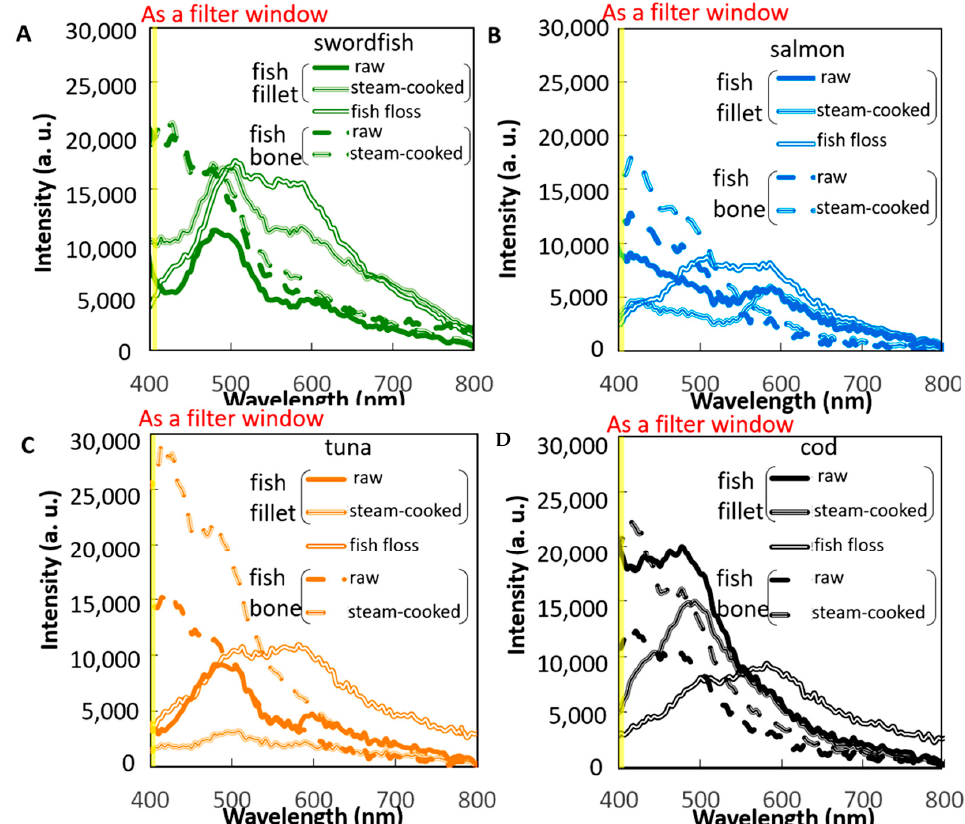
Figure 5. Fluorescent spectrum of fish meat and its fish bone under different cooking conditions (raw, steam cooked, and fish floss) corresponding to the four fish types of ( A ) swordfish, ( B ) salmon, ( C ) tuna, and ( D )